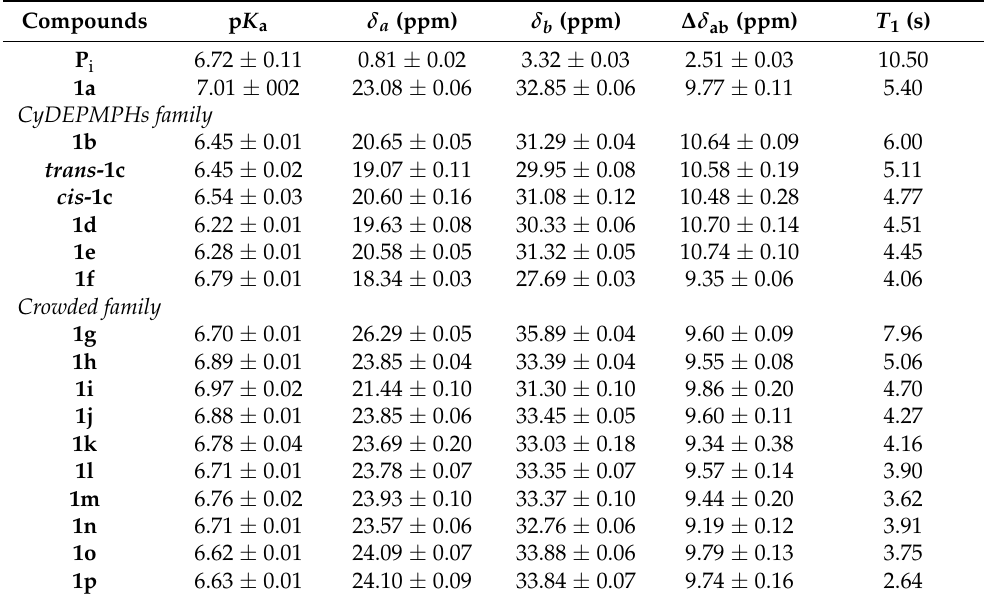
Table 2. 31 P NMR Parameters and p K a Values a in KH Medium at 22 ◦